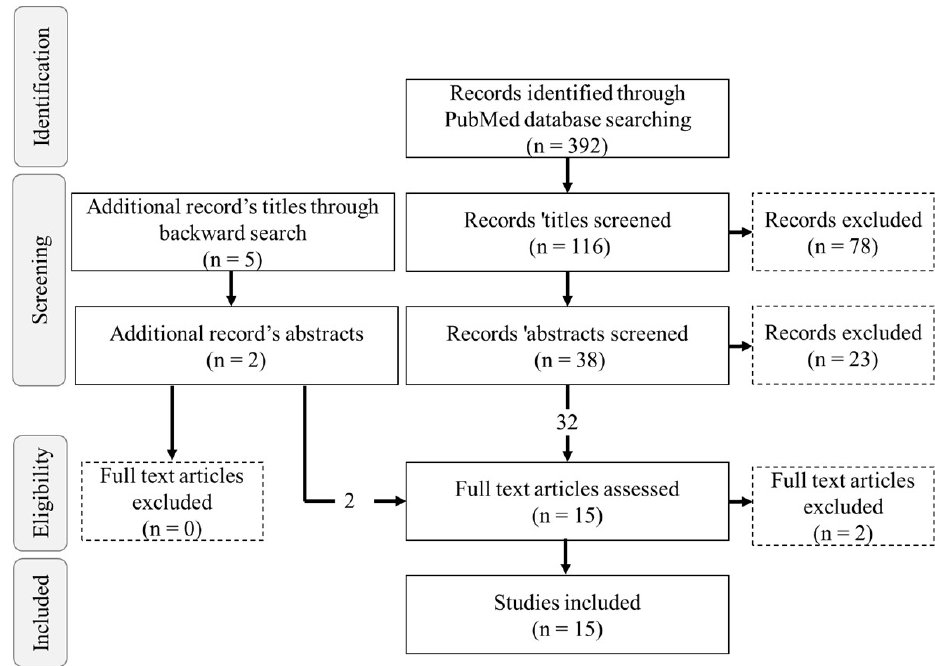
Figure 1. PRISMA flow chart of records based on initial PubMed database searches and backward searching.